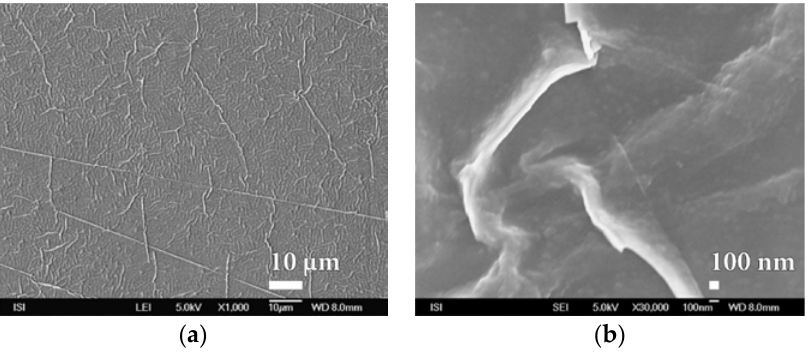
Figure 9. SEM micrographs of PVDC foil surface laminated to PEVA foil after short exposure to oxygen plasma treatment at magnification of ( a ) 1000× ( b ) 30,000×.